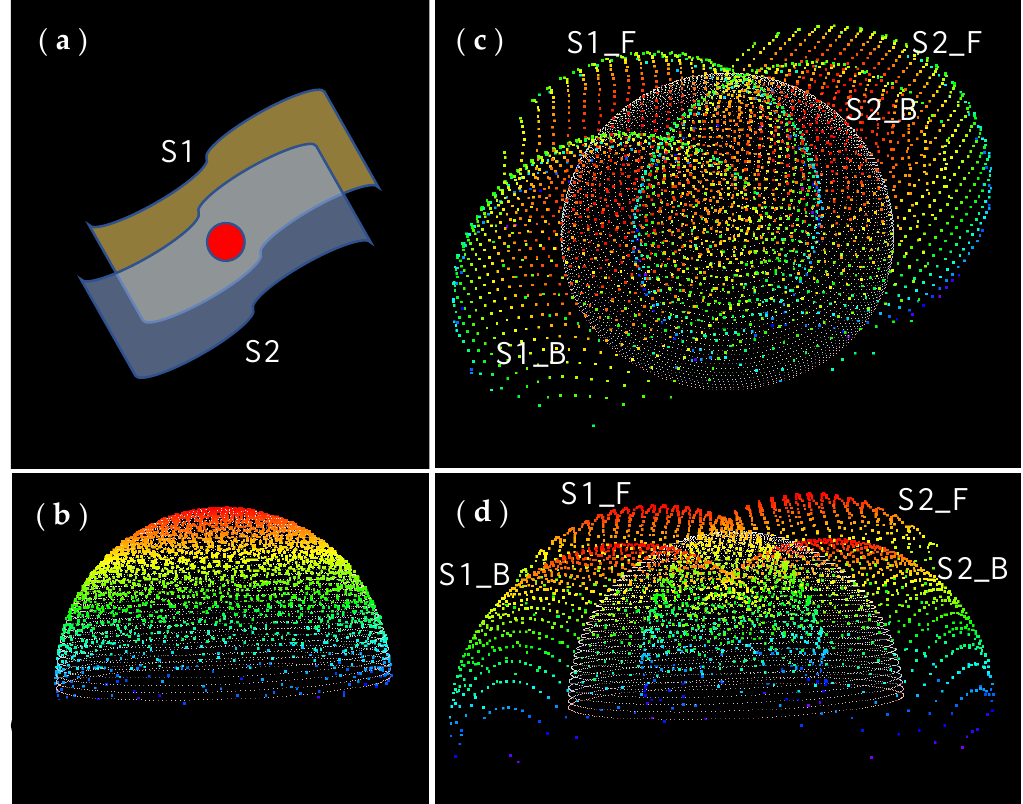
Figure 5. Boresighting simulation. ( a ) Overlapping two swaths S1 and S2. ( b ) Point cloud of a hemispherical object in a perfect boresighting correction. ( c ) Nadir view of the point cloud in a large boresighting misalignment error further separated to forward (F) and backward (B) scanned point cloud. ( d ) Side view of the point cloud of ( c ) in 3D perspective. The true target hemisphere is represented using small white dots in panels ( c ) and ( d ).